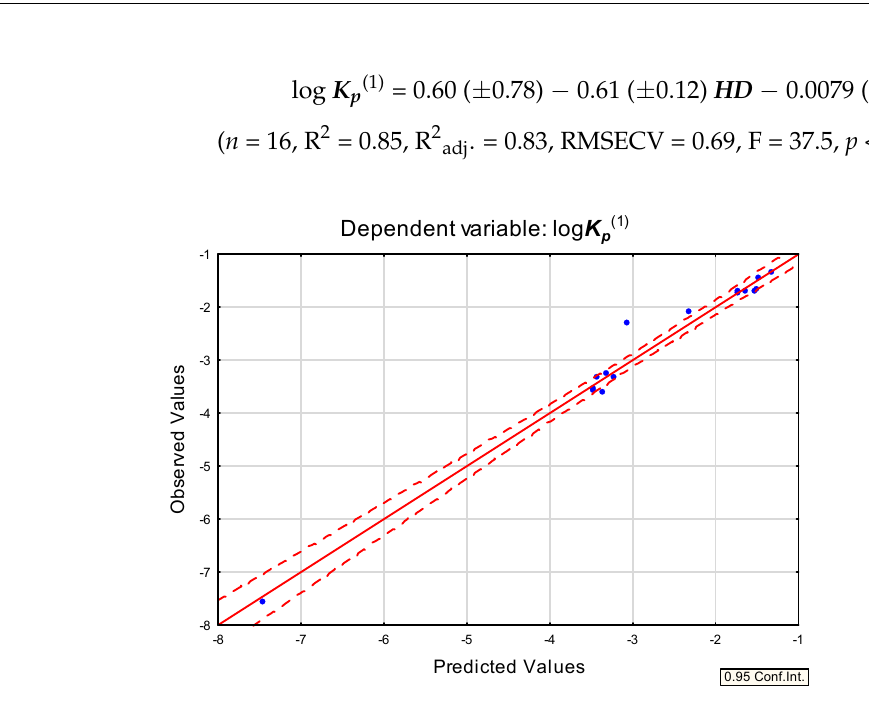
Figure 6. Equation (7) predicted vs. observed values.